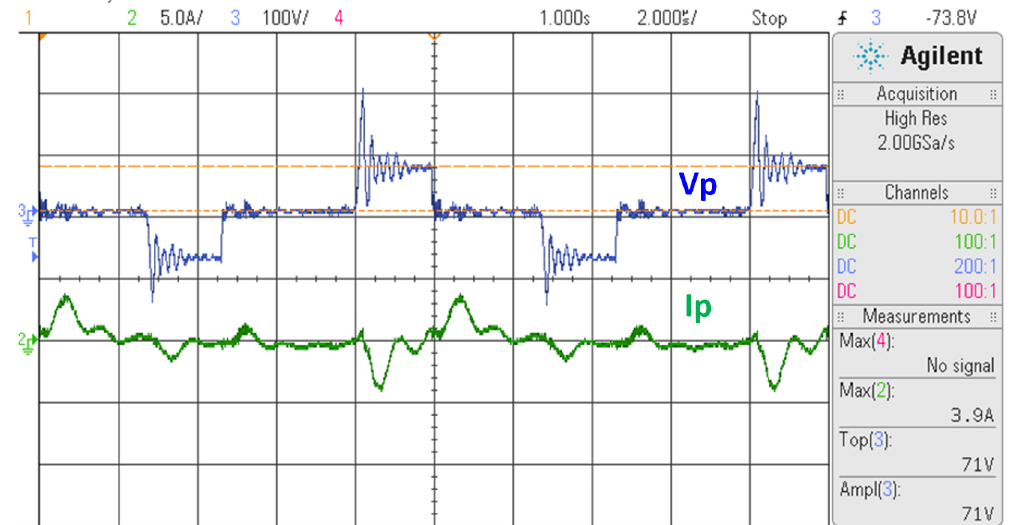
Figure 20. Transformer primary characteristics: Blue—Voltage, Green—current.